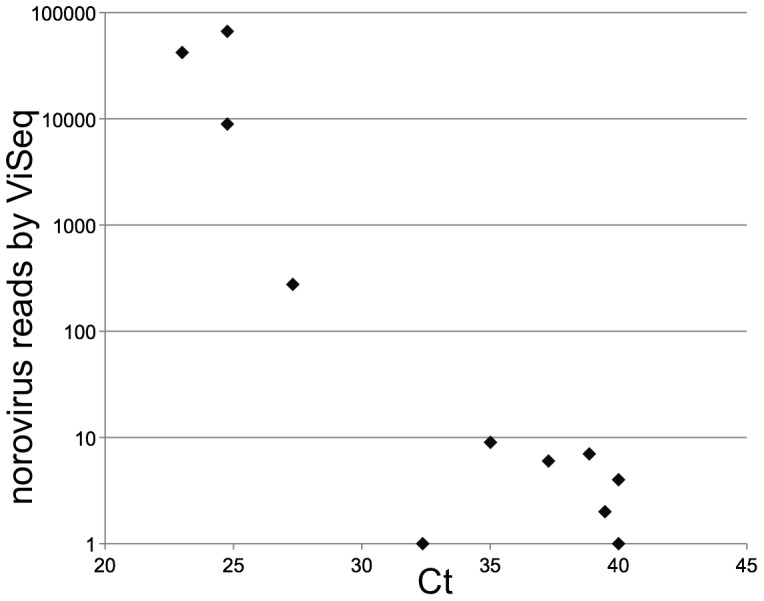
Detection of norovirus by real-time PCR vs the ViSeq process.Total ViSeq identified norovirus reads were compared to the Real time PCR determined norovirus viral loads. Pearson's correlation coefficient for all samples (−0.69), for all samples with Ct values below 35 (0.63) and for all samples with ViSeq reads above 10, (−0.59), indicate a strong negative correlation between the two methods of measurements.